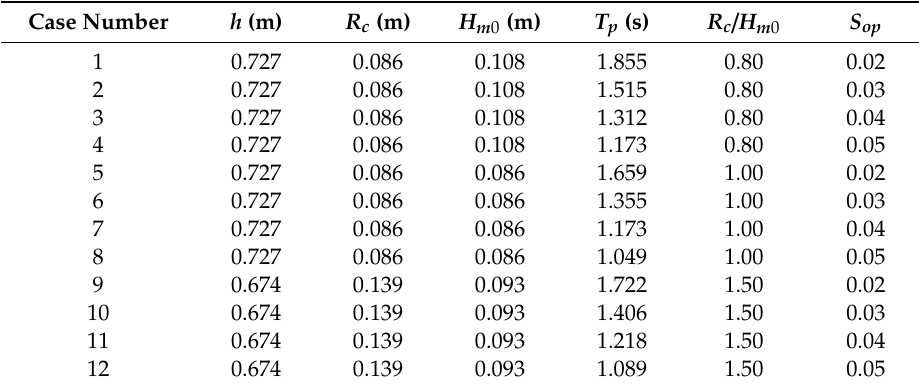
Table 2. Designed breakwater parameters and wave elements.